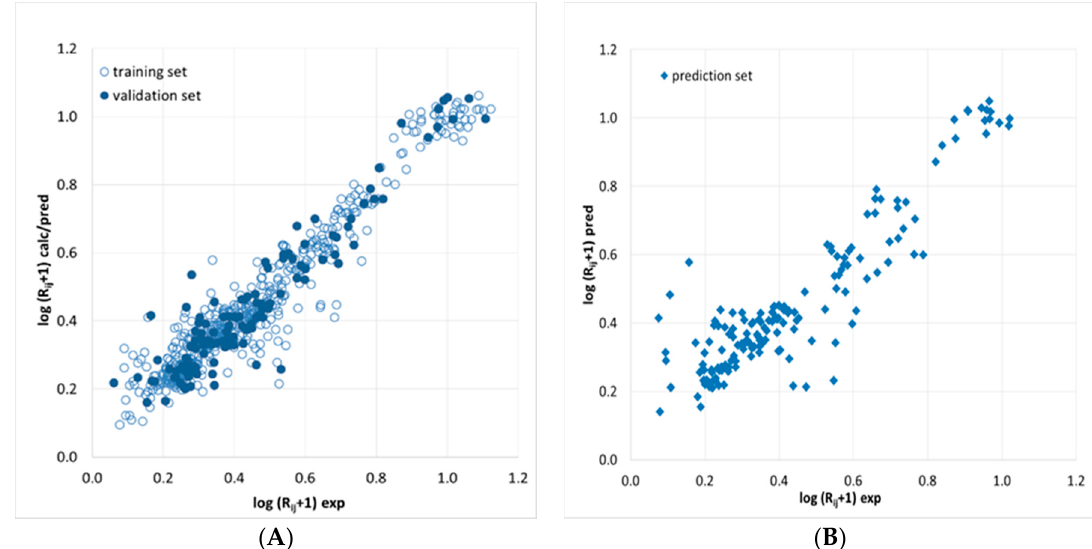
Figure 2. Agreement between ( A ) experimental (exp) resolutions and ( B ) calculated or predicted (calc/pred) responses of the ANN-based model. R ij , resolution of peak pairs.